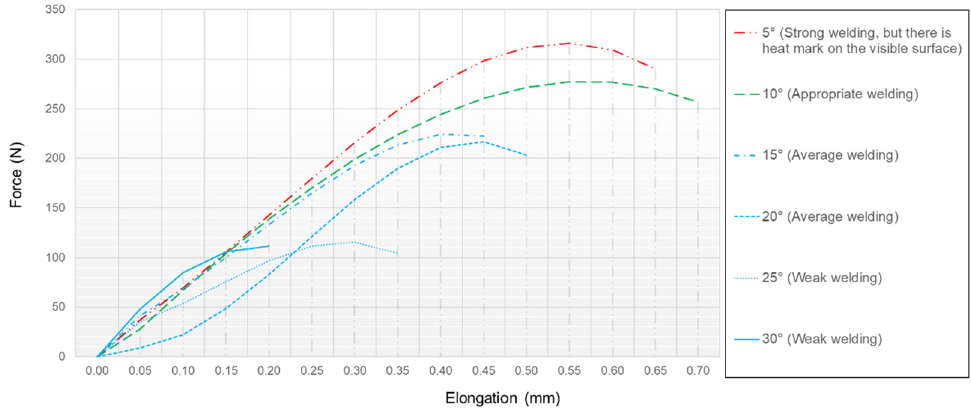
Figure 6. Force–elongation curves of test specimens welded at different torch angles (70.43 Joules).